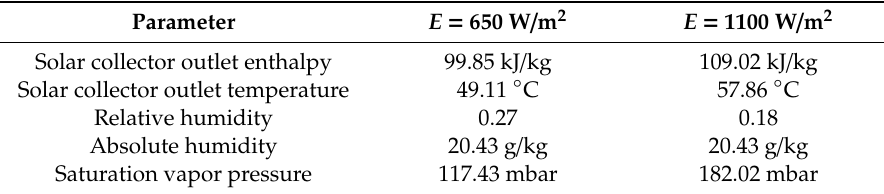
Table 9. Calculated data for the average climatic conditions in